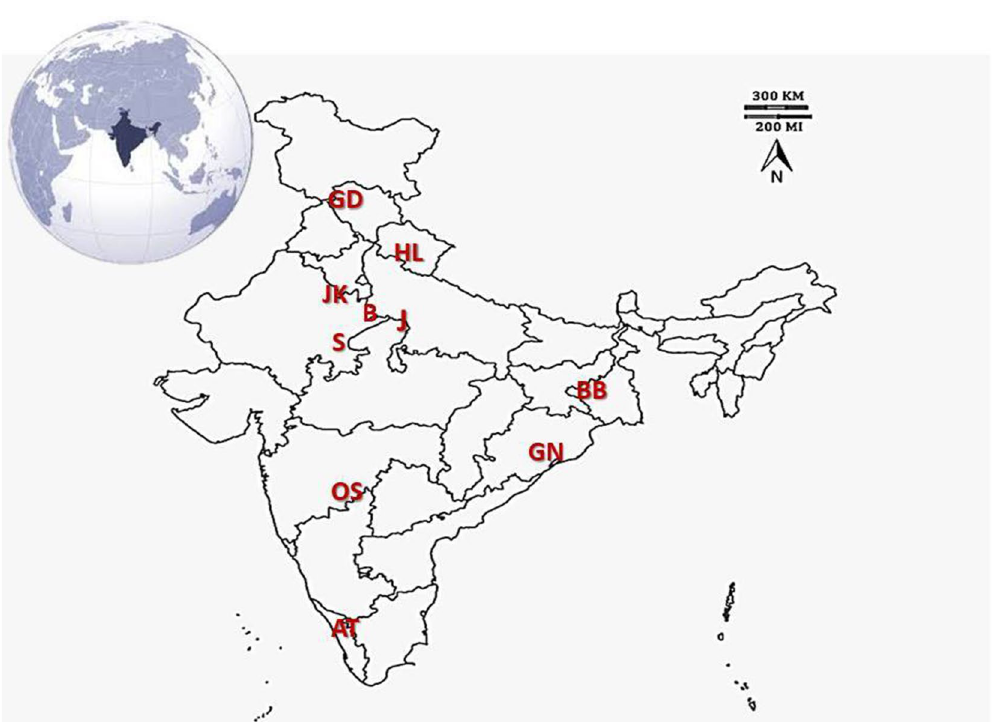
Figure 3. Geographical location of goat milk sampling. The breeds are abbreviated in the region of geographical origin. GD, Gaddi; HL, Himalayan local; JK, Jakhrana; B, Barbari; J, Jamunapari; S, Sirohi; BB, Black Bengal; GN, Ganjam; OS, Osmanabadi; AT, Attapady